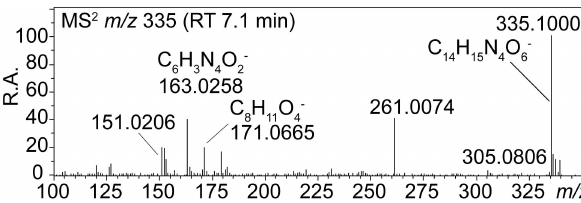
Fig. 5. High-resolution MS 2 data for the m / z 335